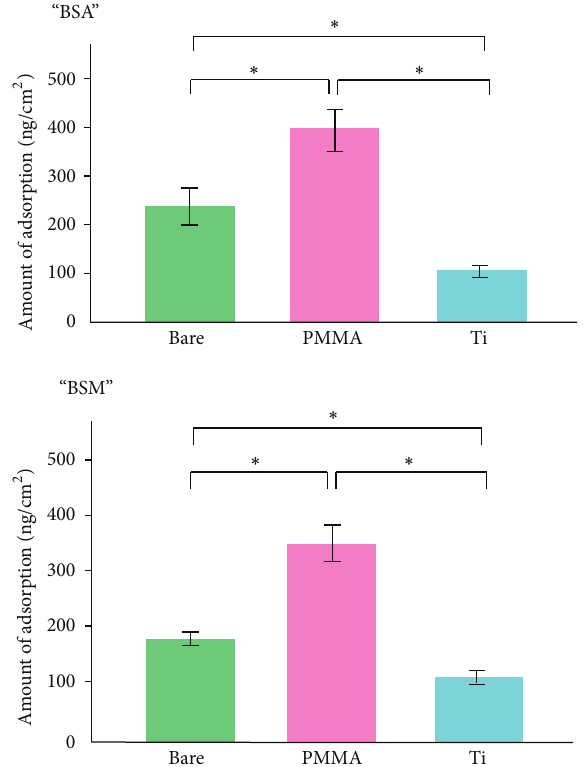
Figure 7: QCM measurements for estimating adsorbed amounts of BSA and BSM to bare, PMMA, and Ti QCM sensors. Data are mean ± SD, 𝑛 = 3 . ∗ denotes a statistically significant difference ( 𝑝 < 0.05